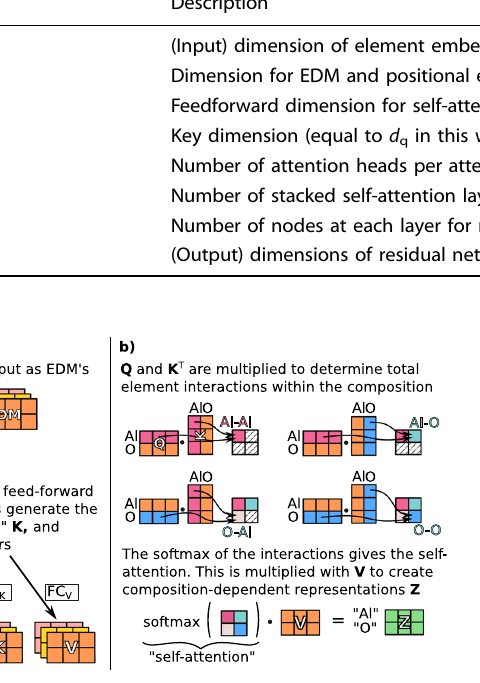
Fig. 7 Schematic of an attention block in the CrabNet archi- tecture. a The initial projection of the input EDM into the Q , K and V tensors. b The scaled dot-product attention operation obtaining the self-attention matrix and the updated Z element representation. The batch dimension is not shown in b to improve